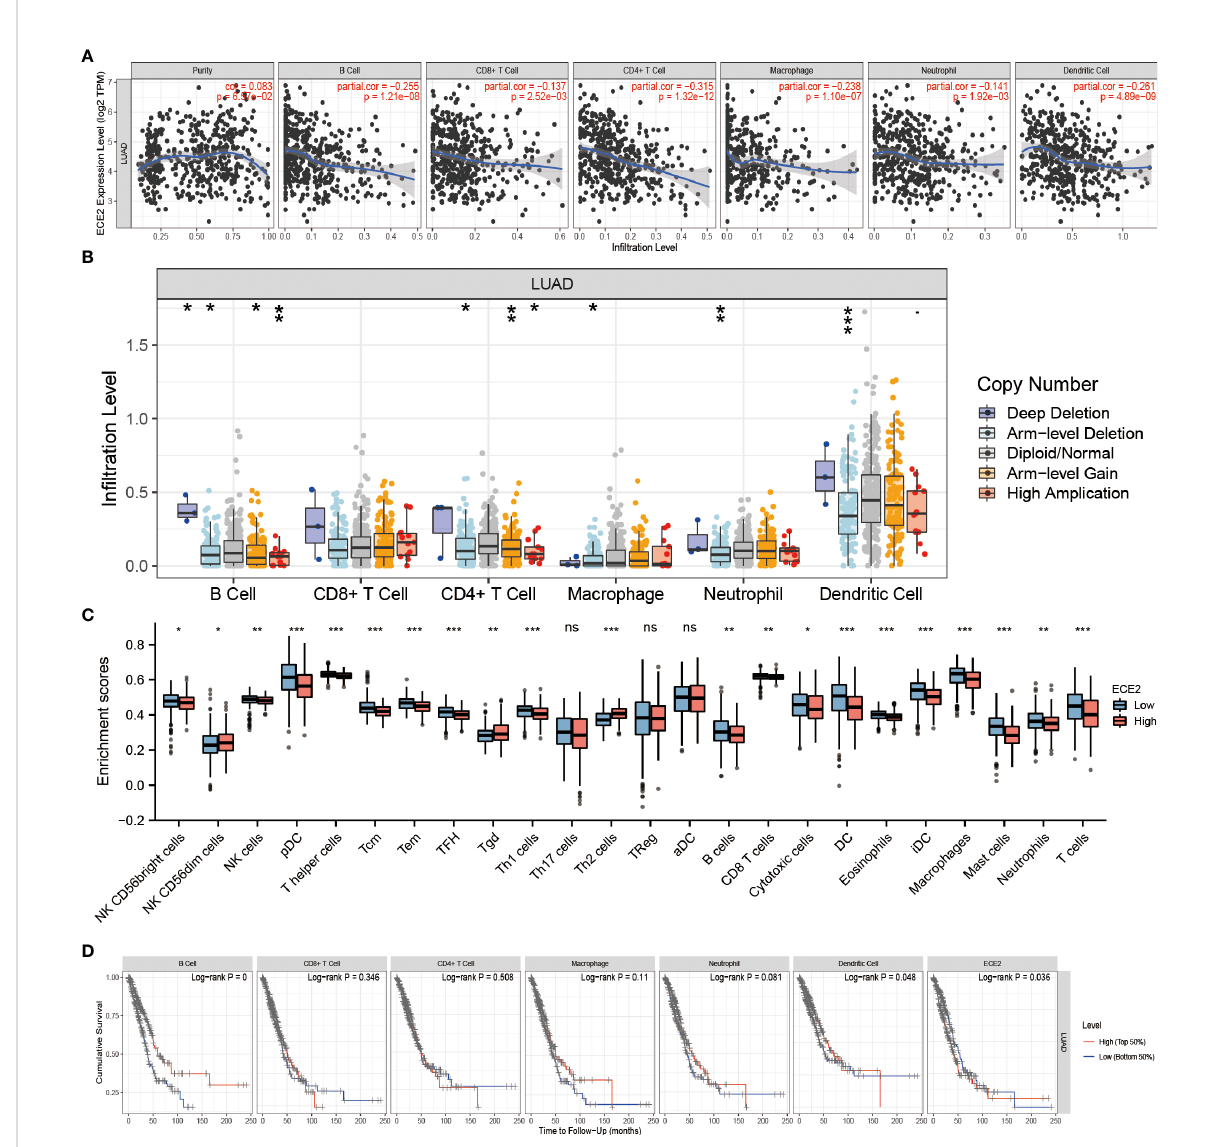
FIGURE 5 Correlation between ECE2 and Tumor Immune In fi ltrating Cells. (A) Correlation between ECE2 expression and immune in fi ltrating cells in LUAD (Spearman correlation analysis). (B) ECE2 CNV affects the in fi ltrating levels of B cell, CD4+ T cell, macrophages, neutrophils, and dendritic cells in LUAD. (C) Changes in 24 immune cell subtypes between high and low ECE2 expression groups in LUAD tumor samples (Wilcoxon rank sum test). (D) Kaplan-Meier plots of immune in fi ltration and ECE2 expression levels in LUAD. (Logrank test) *P < 0.05; **P < 0.01; ***P < 0.001. ns, not signi fi